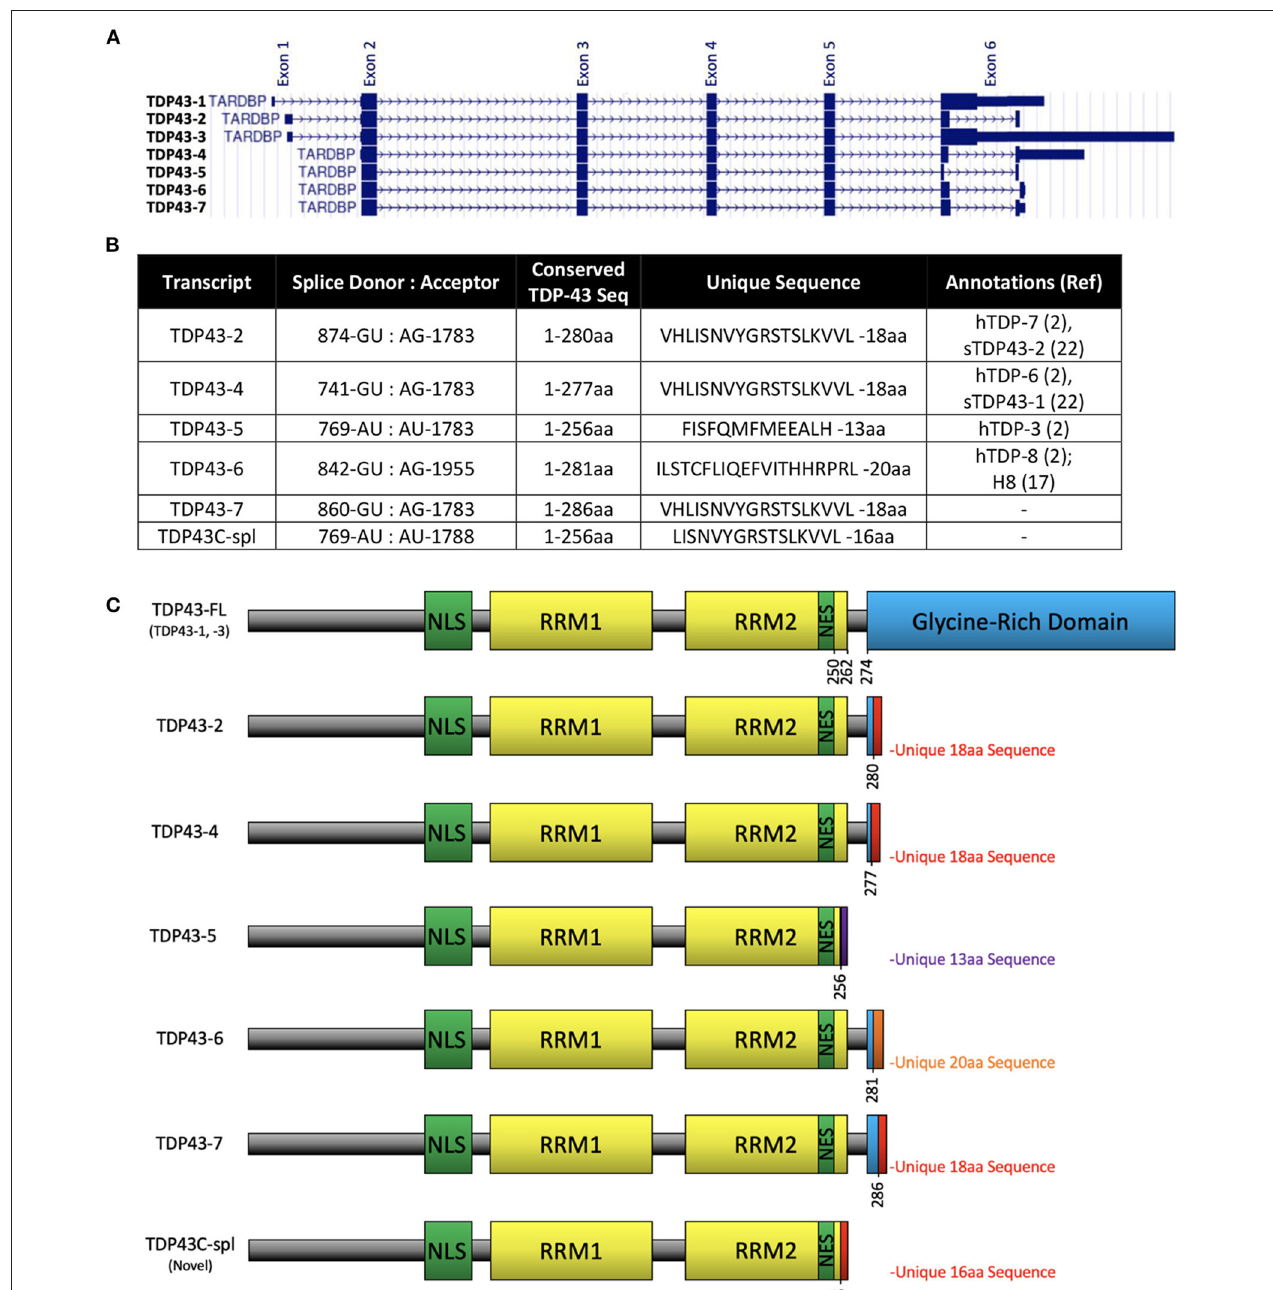
FIGURE 1 | Alternative splice variants transcripts of TARDBP . (A) Reference assembly of 7 alternate haplotype transcript sequence alignments of TARDBP as shown on UCSC genome browser on human (GRCh38/hg38) assembly (https://genome.ucsc.edu) named as TDP43-1 to − 7 corresponding to gencode transcripts ENST00000639083.1, ENST00000629725.2, ENST00000240185.8, ENST00000315091.7, ENST00000649624.1, ENST00000616545.4, ENST00000621790.4, respectively. (B) Table showing previously identified sTDP-43 and TDP43C-spl splice donor and acceptor dinucleotides, number of conserved amino acids from TDP-43FL, the unique sequences at the C-terminus, and other annotations previously assigned to each isoform. (C) Domain structures of TDP-43 protein expressed from each transcript showing the nuclear localization sequence (NLS), RNA recognition motifs (RRM1 and RRM2), nuclear export signal (NES), glycine-rich domain and unique sequences that arise from the alternative splicing